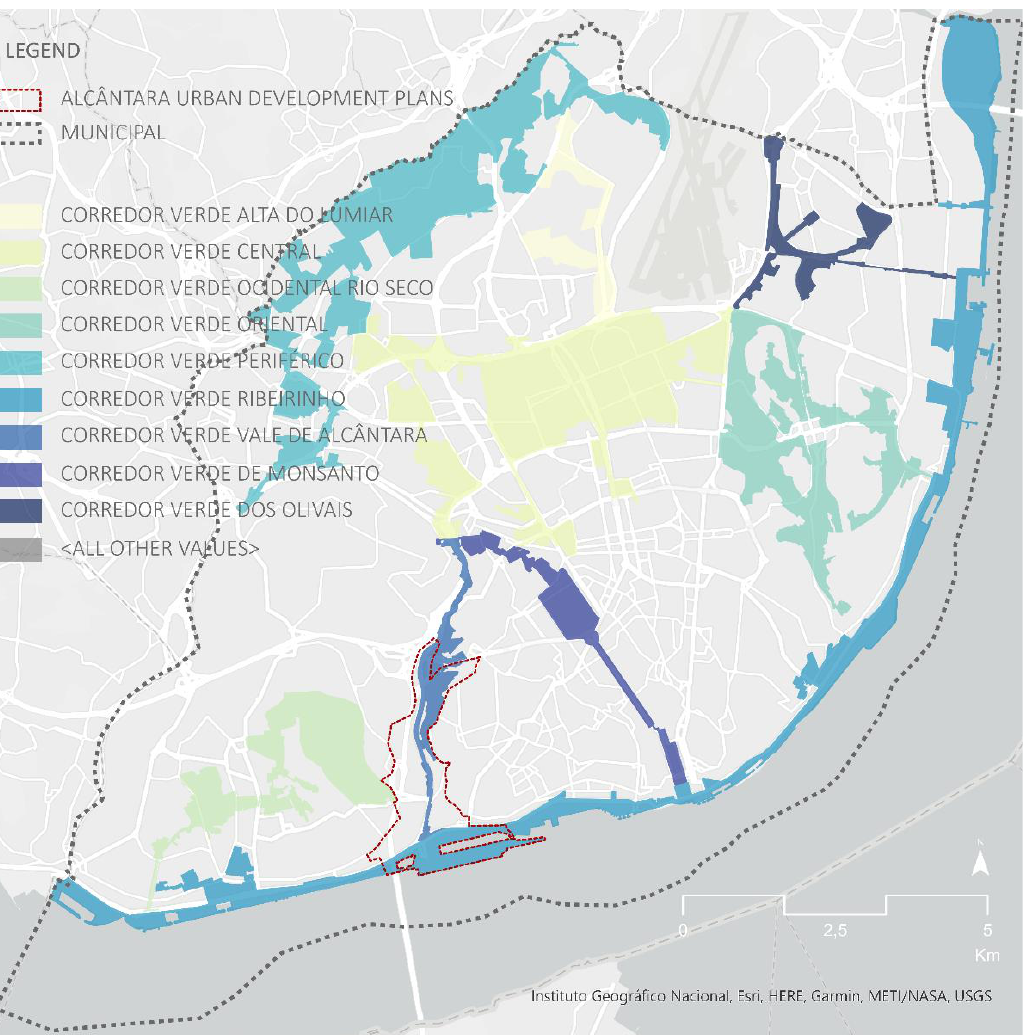
Figure 5. Green Corridors and Green Spaces, Green Spaces and Environment Department/Lisbon City Council, and the active Urban Development Plan (red) for Alcântara. Sources: Own production adapted from CML open-source databases (see Backmatter, 07/11/2021).